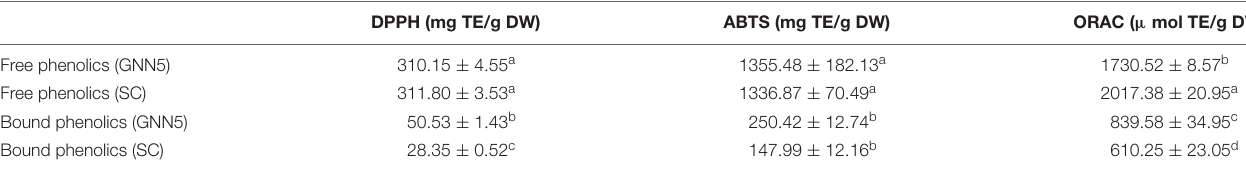
TABLE 2 | Antioxidant capacity of free and bound phenolic compounds extracted from two R. roxburghii leaves.